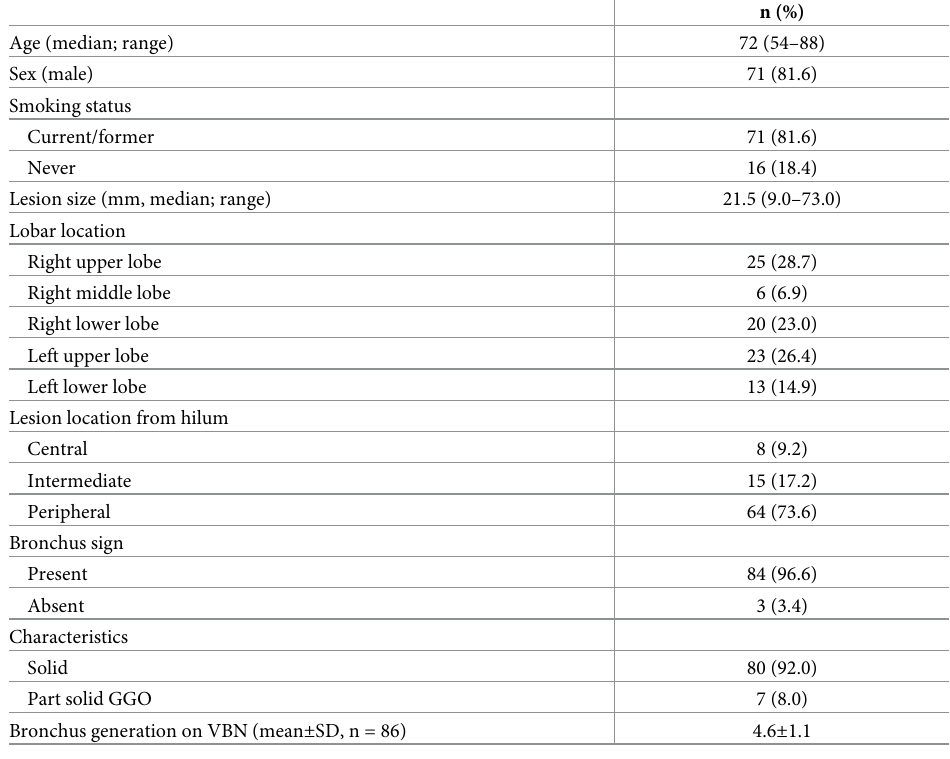
Table 2. Characteristics of the 87 patients who were prospectively